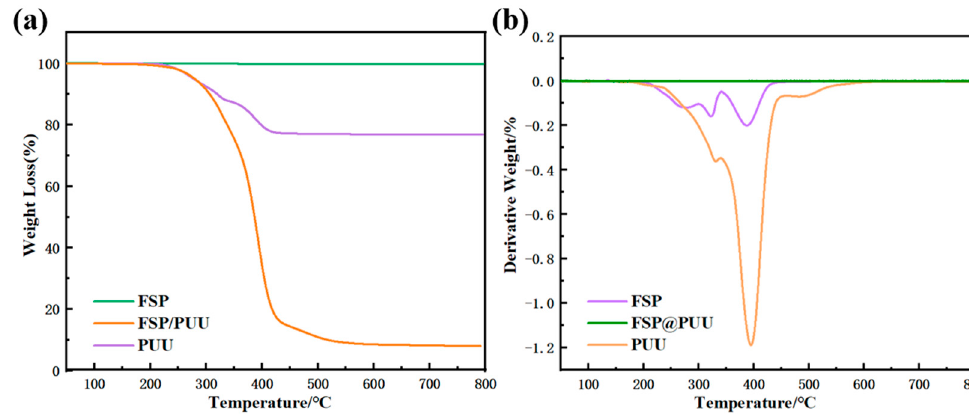
Figure 7. TGA ( a ) and DTG ( b ) curves of the FSP, PUU and FSP@PUU.